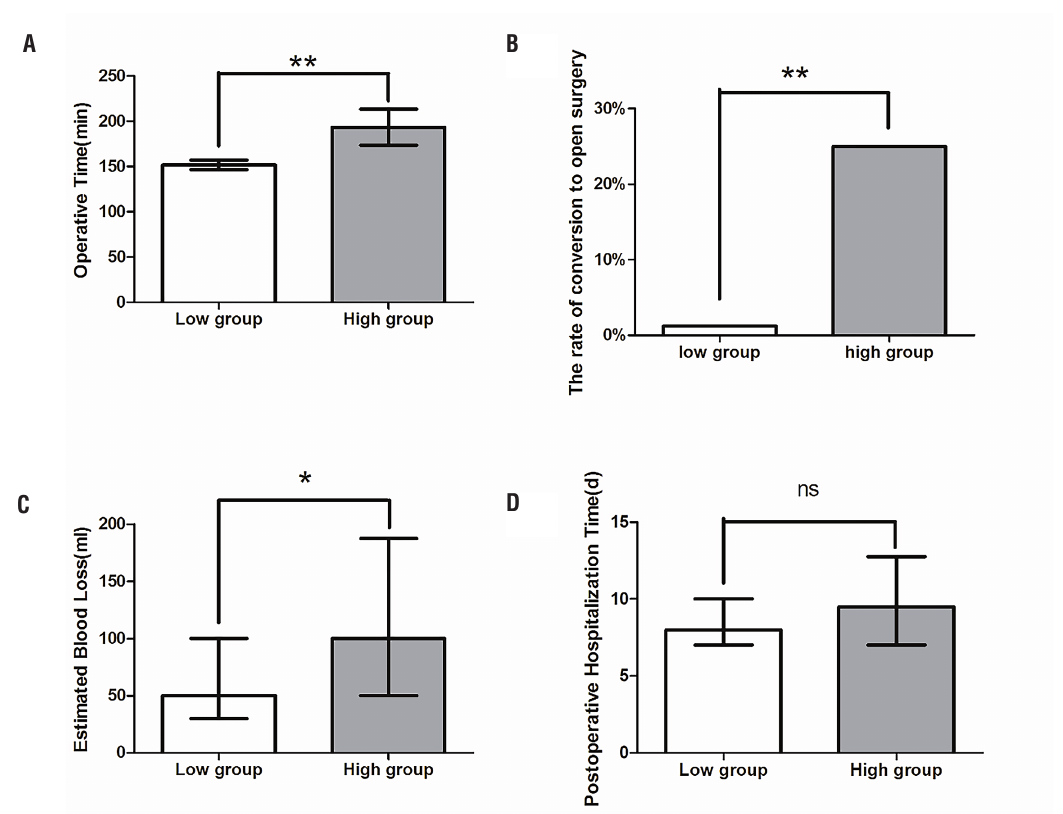
Figure 1 - There were 83 and 12 patients in low (white bar) and high (gray bar) complexity groups respectively. And clinical outcomes analysis of patients treated with LRSN in two groups as the bar chart indicated. Operative time (A): OT of high complexity group was significantly longer than that of low complexity group (The mean OT was 193.2±69.3 min in high group and 151.9±46.3 min in low group, p = 0.008 by the two-sample t-test); the rate of conversion to open surgery (B): the high complexity group has a significantly higher rate of intro-operative conversion to open surgery (The rate of intro-operative conversion to open surgery was 25% in high group and 1.2% in low group, p = 0.006 by Chi-squared test); estimated blood loss (C): EBL of high complexity group was also significantly more than that of low complexity group (The median EBL was 100.0mL in high group and 50.0mL in low group, p = 0.034 by the Wilcoxon signed-rank test); and postoperative hospitalization time (D): no remarkable differences were observed between two groups relating to PHT (The median PHT was 8.0 d in high group and 9.5 d in low group, p = 0.187 by the Wilcoxon signed-rank